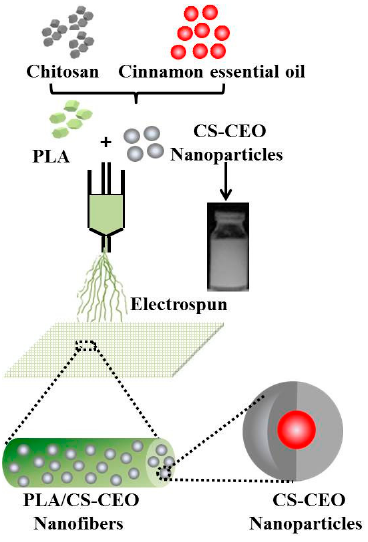
Figure 1. Schematic diagram of the steps for preparing the poly(lactic acid)/chitosan-cinnamon essential oil (PLA/CS-CEO) fibers used in the experiments.